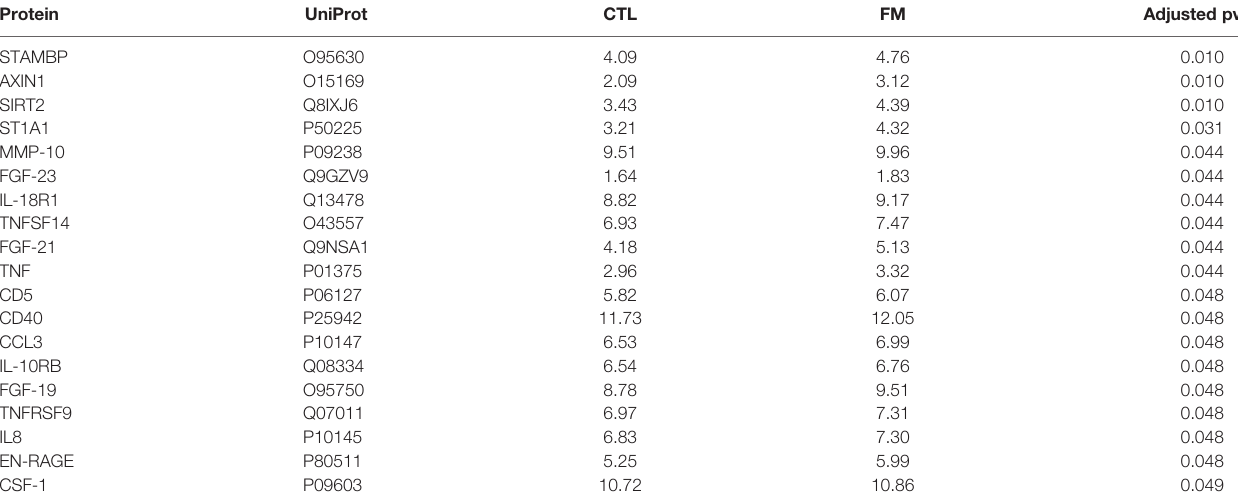
List of differentially expressed serum proteins levels between FM patients (FM; 30 patients) and controls (CTL; 23 healthy individuals), using Olink In fl ammatory panel. Protein levels are expressed as normalized protein expression (NPX) values (log2 scale). Signi fi cant threshold is set as adjusted p-value < 0.05.